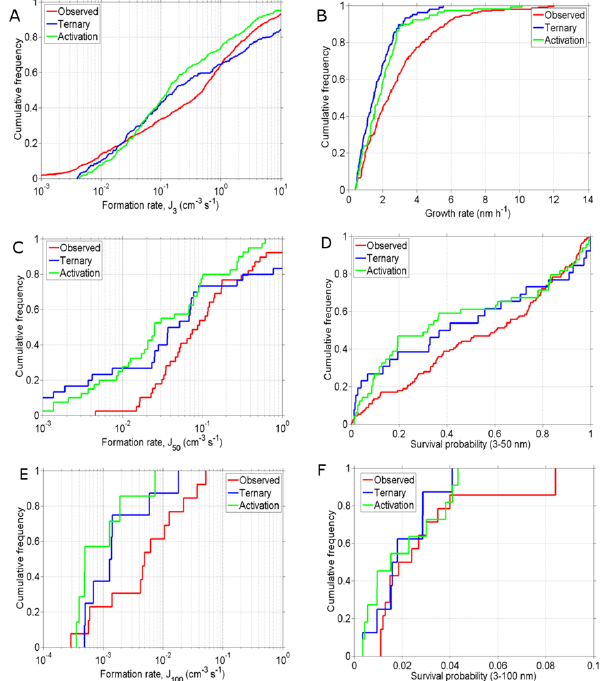
Fig. 7. Same as in Fig. 5, for modeled and measured nucleation metrics at Atlanta